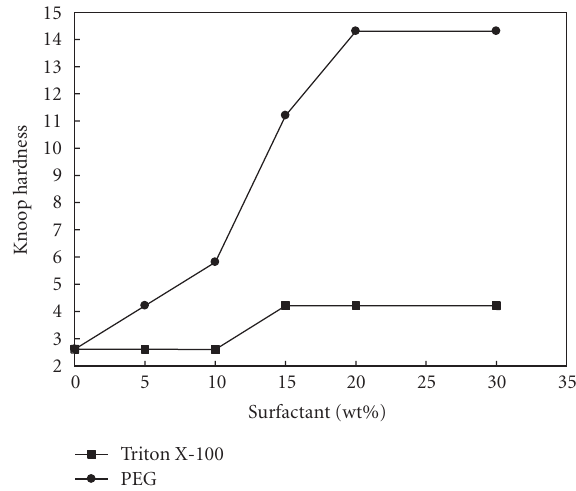
Figure 1: E ff ect of surfactant addition on the P25 thin film hard-